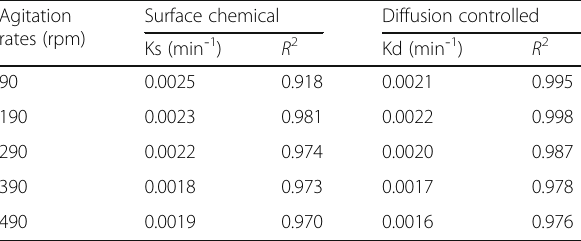
Table 3 Rate constants and R 2 at different agitation rates Agitation rates (rpm)